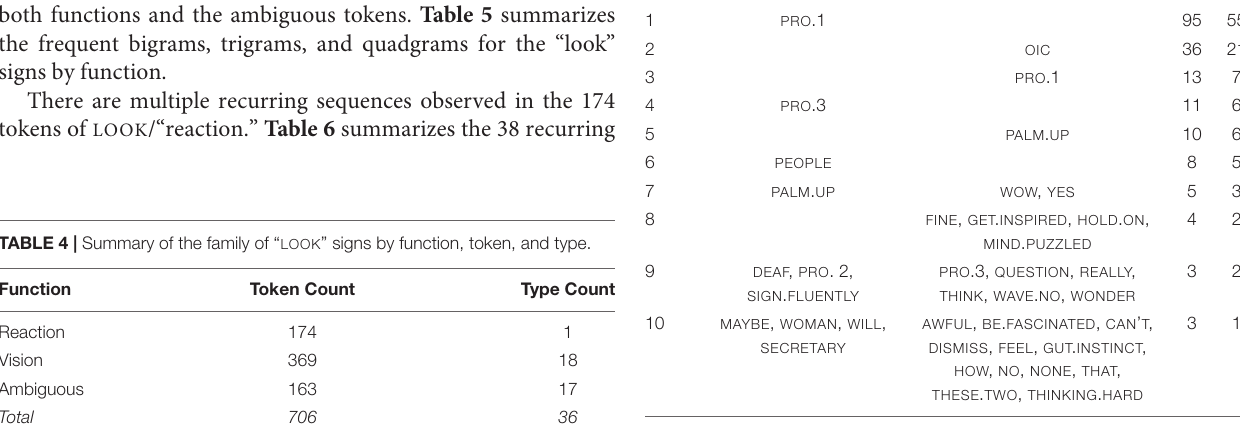
TABLE 5 | Summary of frequent (n ≥ 2) n-grams of the “look” signs. Function